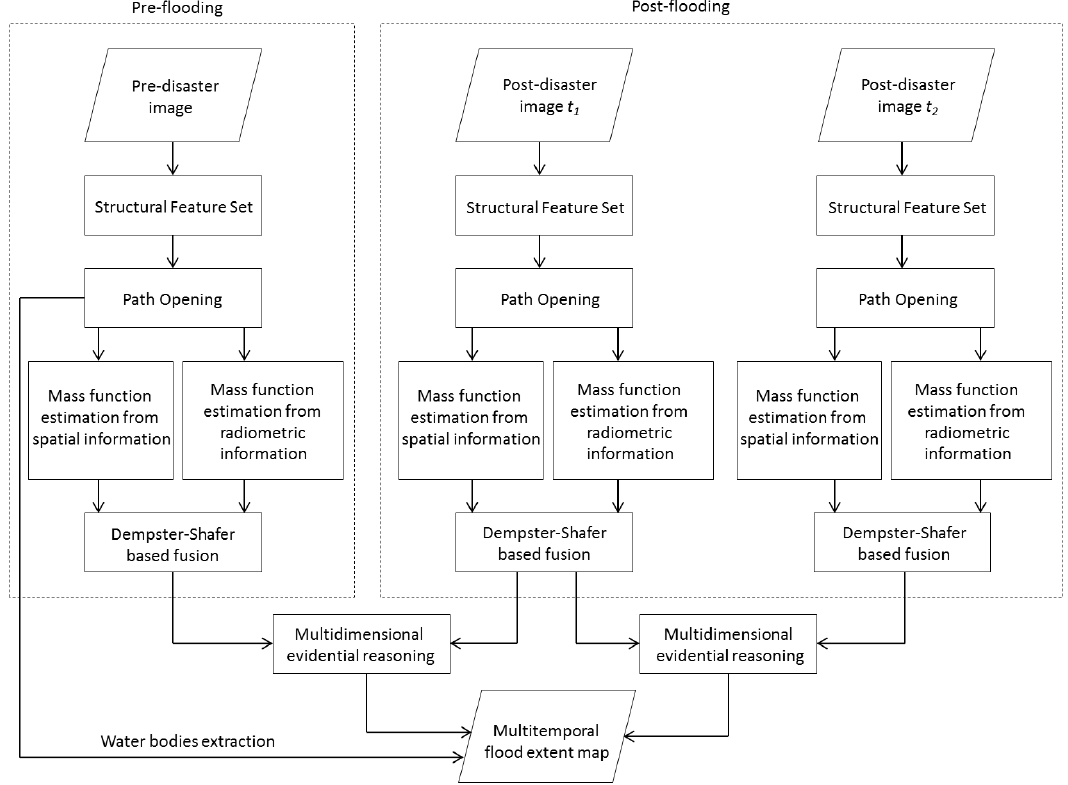
Figure 2. Flowchart of the proposed